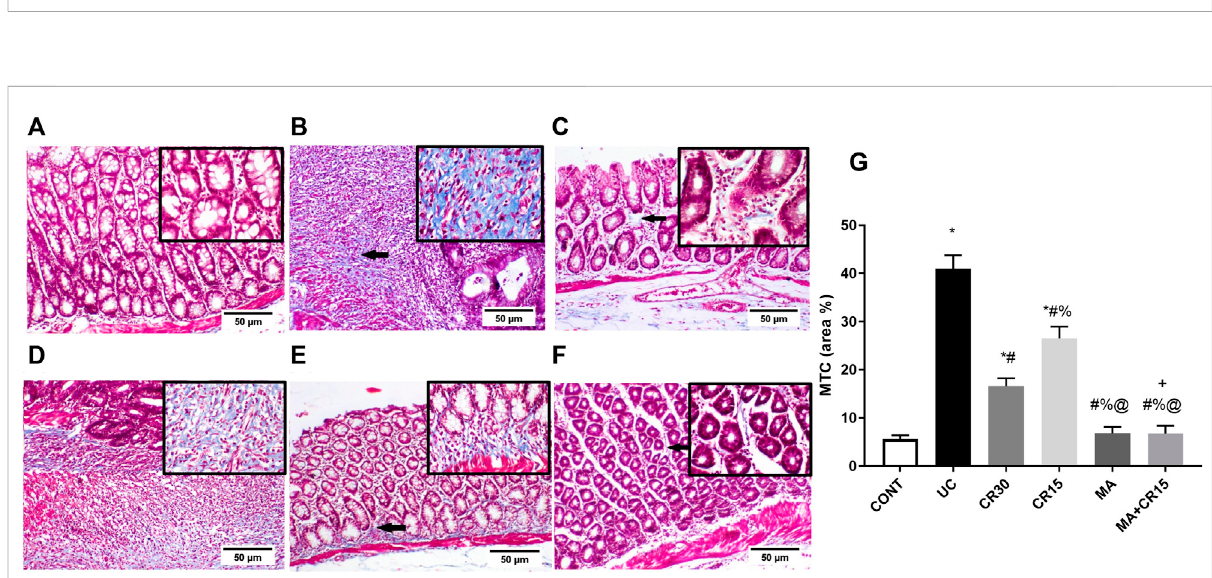
FIGURE 10 Effect of mirabegron and/or carvedilol on MTC stained collagen fi bers in the colon of rats with IAA-induced ulcerative colitis. Panels of A-F represent colon photomicrographs stained with MTC (scale bar, 50 μ m). Section of (A) CONT shows normal weak MTC stained collagen fi bers, whereasthesectionof (B) ulcerated grouprevealsamarkedincreaseincollagen fi bersdeposition.Treatmentwith (C) CR30and (D) CR15 showmild and moderate increases in collagen fi bers deposition, respectively. However, treatment with (E) MA and (F) MA+CR15 reveals weak collagen fi bers deposition (arrows). (G) shows the % area of MTC staining (5 fi elds in each section). Data are presented as mean ± SD (n = 3 rats/group). Statisticalanalysis wascarriedoutusingone-wayANOVAfollowedbyTukey ’ s posthoc test; p < 0.05,ascomparedtothe(*)CONT,(#)UC,(@)CR15, and (%) CR30 groups. (+) Indicates additive interaction using CDI. CDI, coef fi cient of drug interaction; CONT, control; CR, carvedilol; IAA, iodoacetamide; MA, mirabegron; MTC, Masson ’ s Trichrome; UC, ulcerative